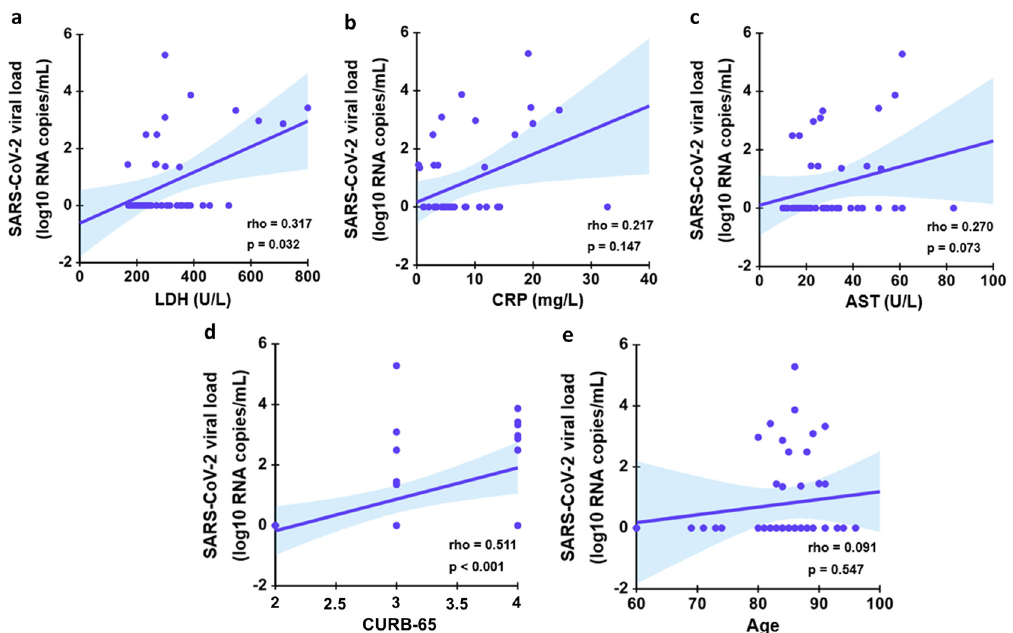
Figure 5. Correlation between viral load and other factors at baseline. Analysis of the association between LDH ( a ), CRP ( b ), AST ( c ), CURB-65 ( d ) and Age ( e ) with serum viral load. p values are obtained from Spearman correlation coefficient rho.